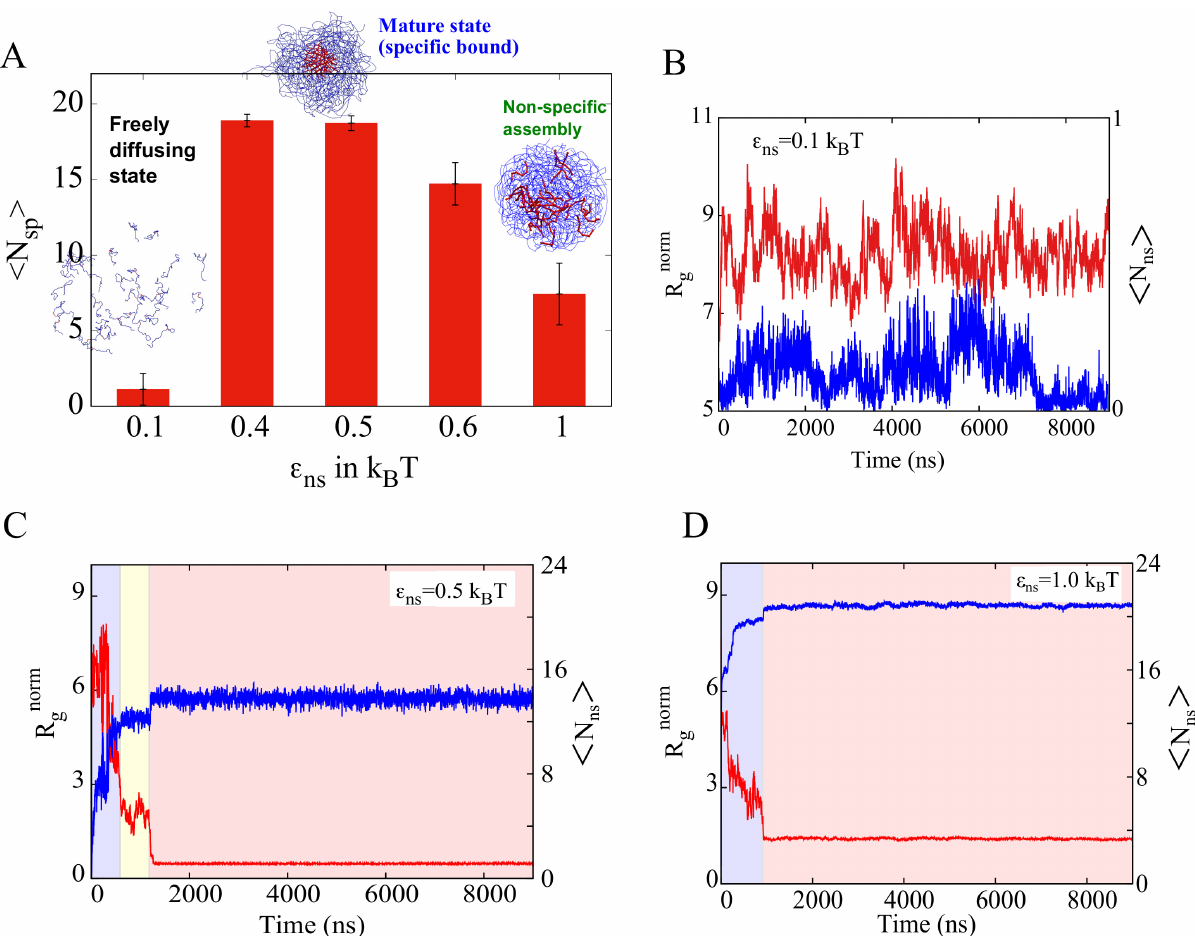
Fig 4. State of multimeric system for varying strengths of � ns . A) Average number of specific interaction per bead (red-red) N sp for different of non- specific interaction strength � ns values. (B,C,D) Radius of gyration ( R norm ) and Number of non-specific interactions per bead (N ns ) are plotted as a g function of time for � sp = 1.2 k B T. B) For weak � ns = 0.1 k B T we observe neglibile non-specific contacts in the system (N ns � 0). This is accompanied by large values of R norm suggesting that the stable multimers are not observed. C) For � ns = 0.5 k B T, there is an initial regime of low N ns and large R norm g g while the polymer chains are yet to form multimeric clusters. This is followed by a regime (shaded yellow) where there is an increase in N ns suggesting the formation of multimers stabilized by non-specific interactions. This increase in N ns further enables the central functional patches to come in contact, indicated by the further decrease in R norm (red regime). D) A further increase in � ns to 1 k B T results in the initial formation of non-specifically g stabilized multimers without a further reorganization into a functional complex where the central red-patches do not phase-separate into a separate region. At these high values of � ns , the multimers forms a non-specific assembly.